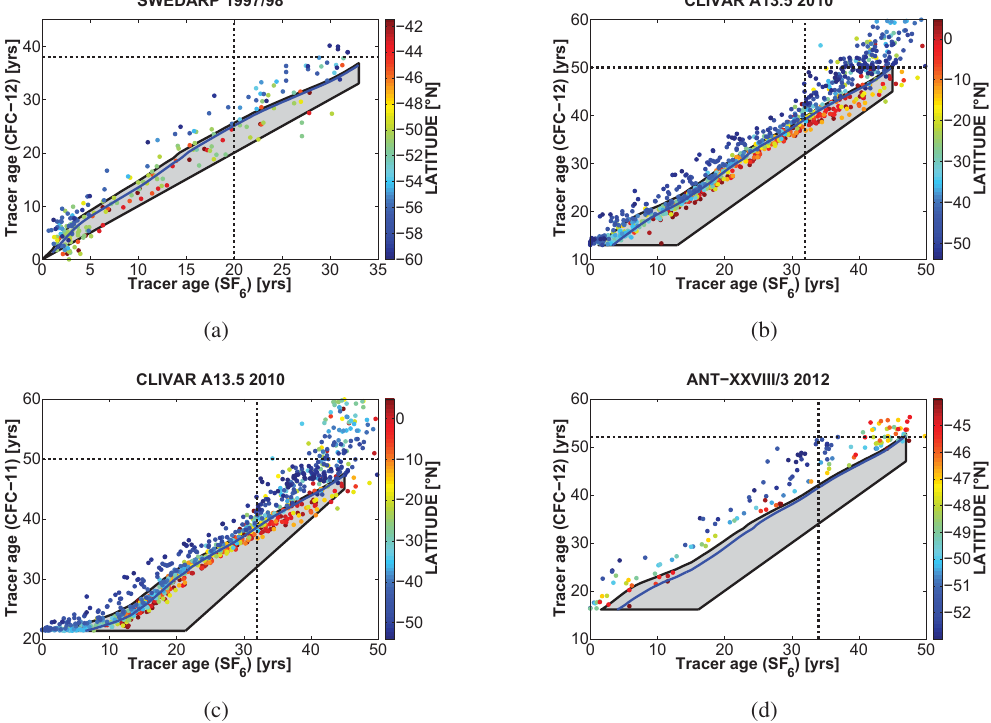
Fig. 7: Validity areas (grey shaded area) and tracer age relationships of ( a ) CFC-12/SF 6 of the SWEDARP cruise of 1998, Figure 7. Validity areas (grey shaded area) and tracer age relationships of (a) CFC-12/SF 6 of the SWEDARP cruise of 1998, (b, c) CFC- 12/SF 6 and CFC-11/SF 6 of the CLIVAR A13.5 cruise of 2010 and (d) CFC-12/SF 6 of the ANT-XXVIII/3 cruise of 2012. The data are ( b , c ) CFC-12/SF 6 and CFC-11/SF 6 of the CLIVAR A13.5 cruise of 2010 and ( d ) CFC-12/SF 6 of the ANT-XXVIII/3 cruise colored by latitude from red (north) to blue (south); the blue line describes the tracer age relationship of the unity ratio (cid:49)/(cid:48) = 1 . 0. The of 2012. The data is colored by latitude from red (north) to blue (south), the blue line decribes the tracer age relationship of north–south trend of (cid:49)/(cid:48) ratios being shifted towards the upper limit of the IG-TTD can be seen for all data sets. The CLIVAR A13.5 data the unity ratio Δ / Γ = 1 . 0 . The north-south trend of Δ / Γ ratios being shifted towards the upper limit of the IG-TTD can be show that the northern data are in the application range of the IG-TTD, whereas ANT-XXVIII/3 data cannot be applied to the model. The seen for all data sets. The CLIVAR A13.5 data show that the northern data is in the application range of the IG-TTD whereas SWEDARP data show a scattered and indistinct structure with no clear trend. The dashed black lines indicate the sensitivity limit that is ANT-XXVIII/3 data cannot be applied to the model. The SWEDARP data shows a scattered and indistinct structure with no explained in Sect. 4.4. clear trend. The dashed black lines indicate the sensitivity limit which is explained in section 4.4. trend, with a mean bottom concentration of 0.15 ppt. The water layer above the AABW consists of Circumpolar Deep Water (CDW), which is split into an upper and lower part (UCDW, LCDW) and mixes with southwards-propagating NADW. The CFC concentrations are 4–20 ppt of CFC-12 and 2–8 ppt of CFC-11 between 1500 and 3000 m and between 40 and 50 ◦ S. Here again, SF 6 is barely detectable. Similar for all three tracers is the decreasing concentration from a nearly saturated surface layer to low tracer concentrations in intermediate layers with concentration gradients correspond- ing to the shape of the pycnocline. Applying the IG-TTD model to the tracer couples CFC- 12–SF 6 and CFC-11–SF 6 , it is shown that the model (i.e., Figure 8. Yearly maximum surface undersaturation of CFC-12, the (cid:49)/(cid:48) ratios) can be constrained for most of the interme- CFC-11 and SF 6 between 50 and 68 ◦ S and between 30 ◦ W and 20 ◦ E in the Southern Ocean. The surface saturation was relatively (Fig. 12). The indicated north–south trend of Fig. 7b and similar for all three transient tracers over the last 30 years. The black and red stars indicate the CFC-12 and CFC-11 mean surface satura- tions that were obtained during the ANT-X/4 cruise in 1992.